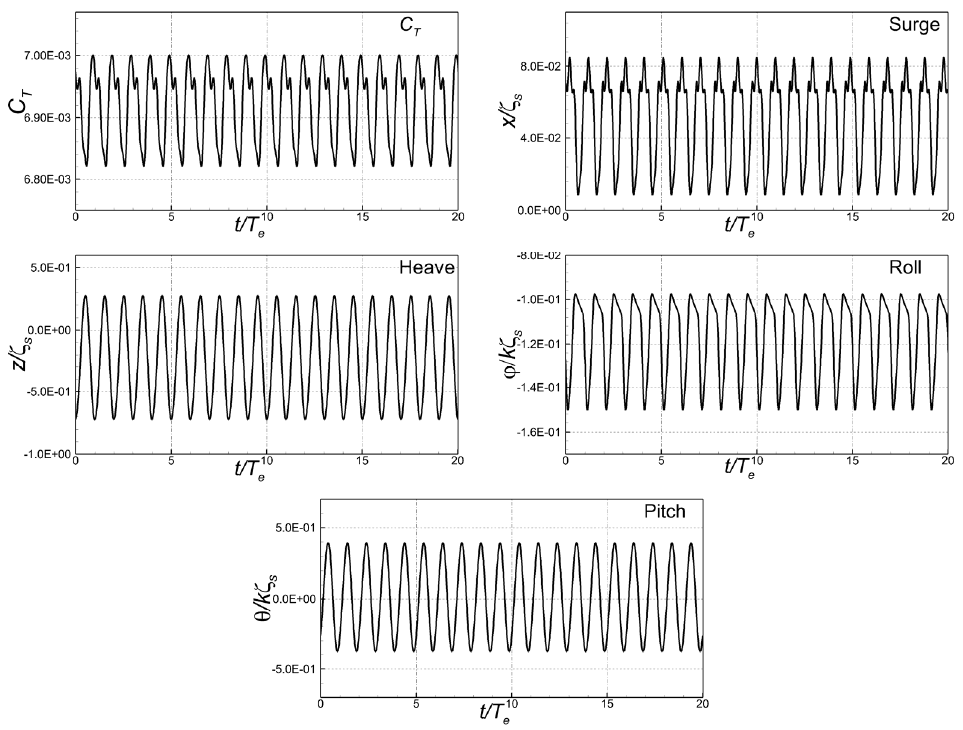
Figure 11. Time histories of the Fourier reconstructed resistance coefficient ( C T ) , surge ( x ) , heave ( z ) , roll ( ϕ ) and pitch ( θ ) for the FRxz ϕθ head waves scenario.